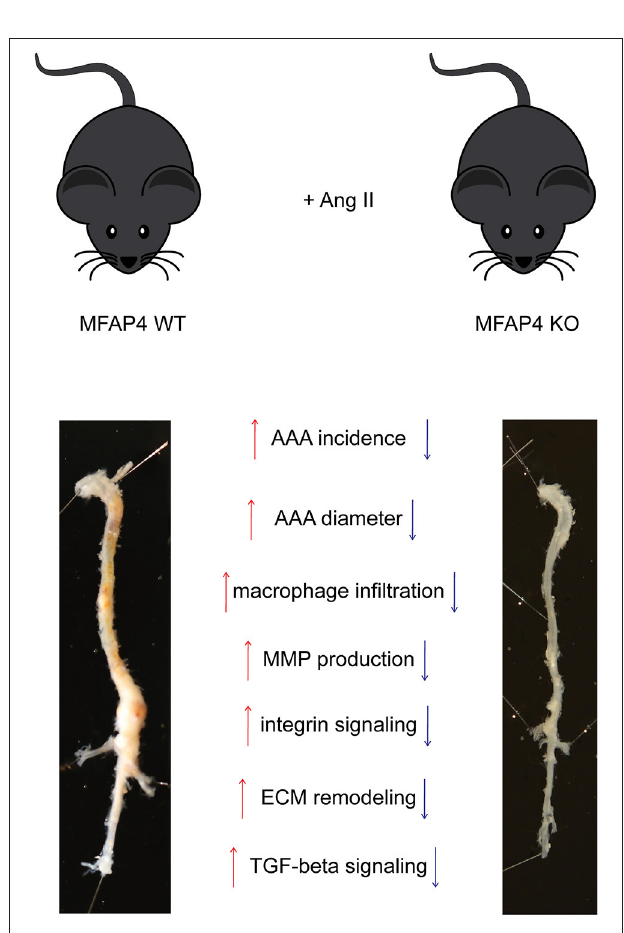
FIGURE 7 | MFAP4 deficiency protects against Ang II-induced AAA pathology. Overview of the identified actions of MFAP4 in Ang II-induced AAA.